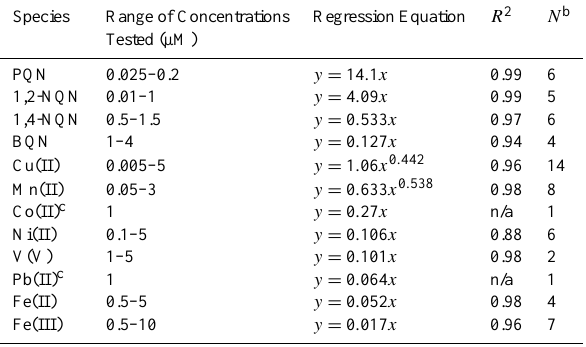
Table 1. Regression equations for DTT loss from individual metals and quinones a . Species Range of Concentrations Regression Equation R 2 N